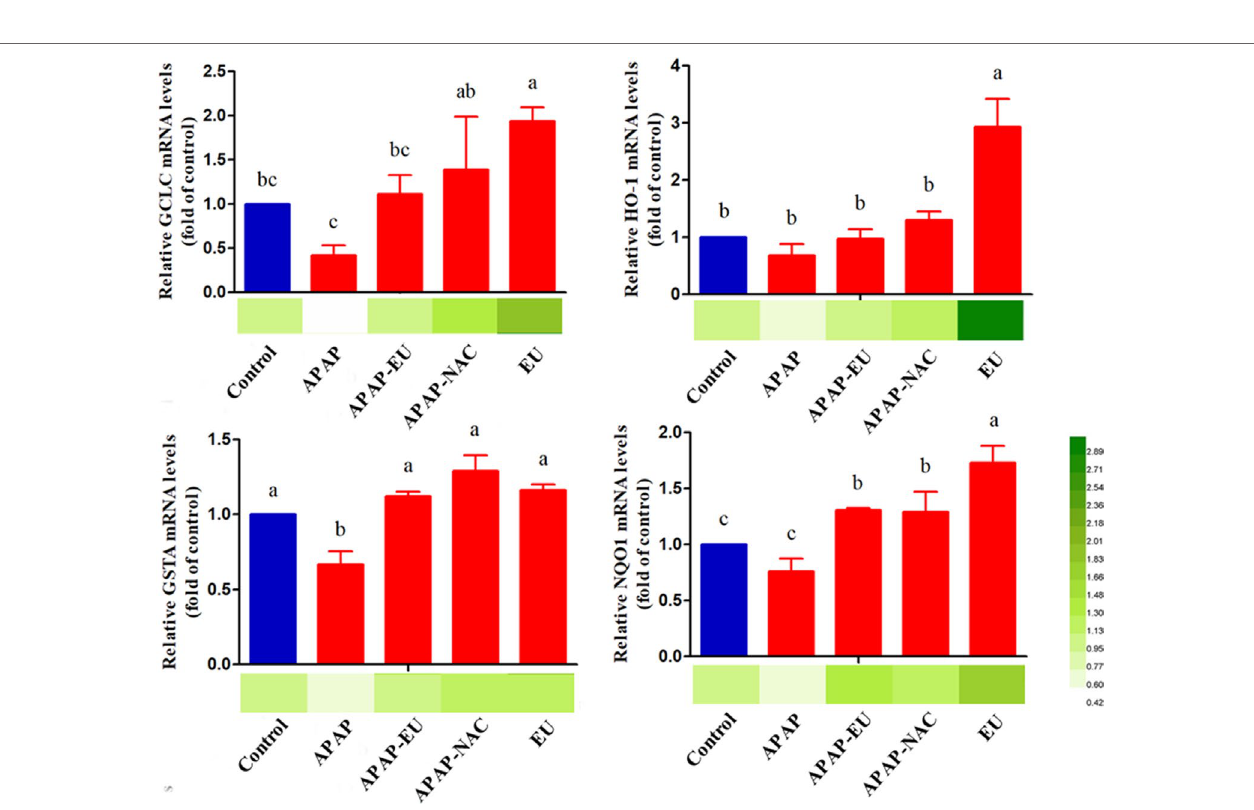
FIGURE 5 | mRNA expression levels of oxidative stress-related genes . a, b, c, d different letters indicate statistically different groups ( p <